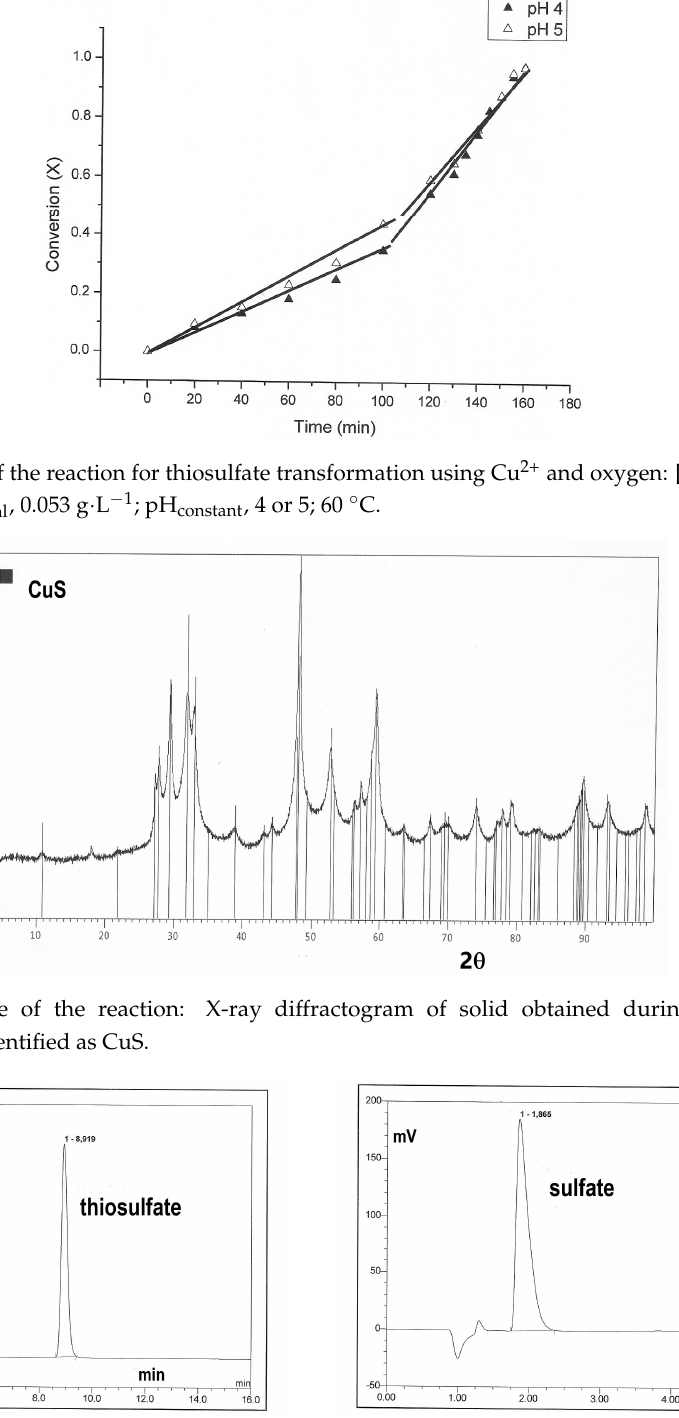
Table 1. Values of k exp of thiosulfate transformation in two steps.